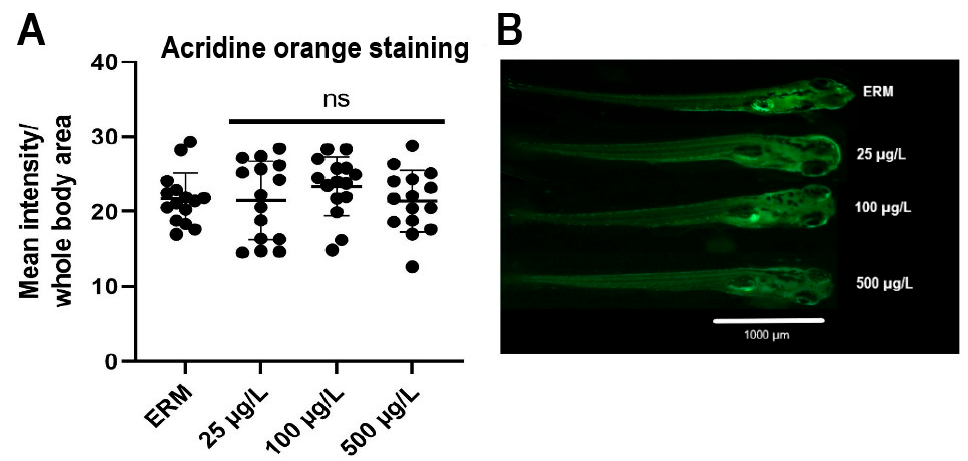
Figure 6. ( A ) Fluorescence intensity (quantified by using the histogram tool of the Image J software) in zebrafish larvae exposed to ERM (control), 25, 100, and 500 µg/L sulfamethoxazole at 7 dpf. Data represented as mean (±SD) (one-way ANOVA followed by Dunnett’s post-hoc test, p > 0.05, n = 15 larvae per treatment). ( B ) Representative photomicrographs of zebrafish larvae stained with acridine orange (AO) dye after being exposed to ERM (control), 25, 100, and 500 µg/L sulfamethoxazole for 7 days. The scale bar is 1000 µm. The abbreviation ns indicates not significant.